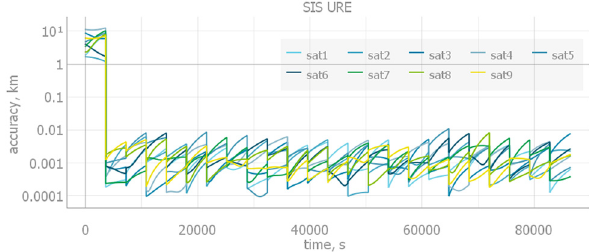
Figure 6: On - board LNSS orbit determination simulation results over 24 h, the measurement interval is 1 h.